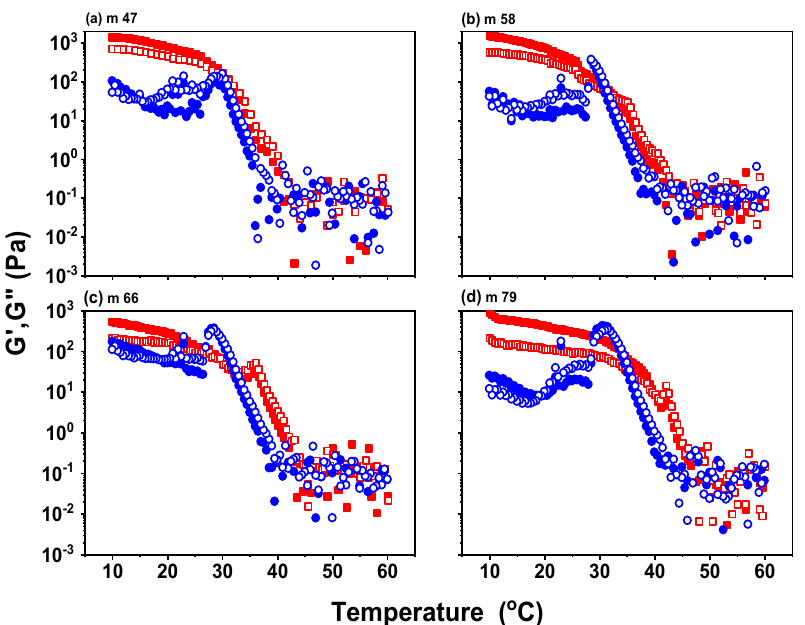
Figure 1. Variations in storage ( G ’, filled symbol) and loss ( G ”, open symbol) moduli of 5% ( a ) m47, ( b ) m58, ( c ) m66, and ( d ) m79 solutions as a function of temperature at a frequency of ω = 10 rad/s and a strain amplitude of γ = 0.1%. Symbols ( ■ , □ ) and ( ● , ○ ) are for heating and cooling sweeps, respectively.